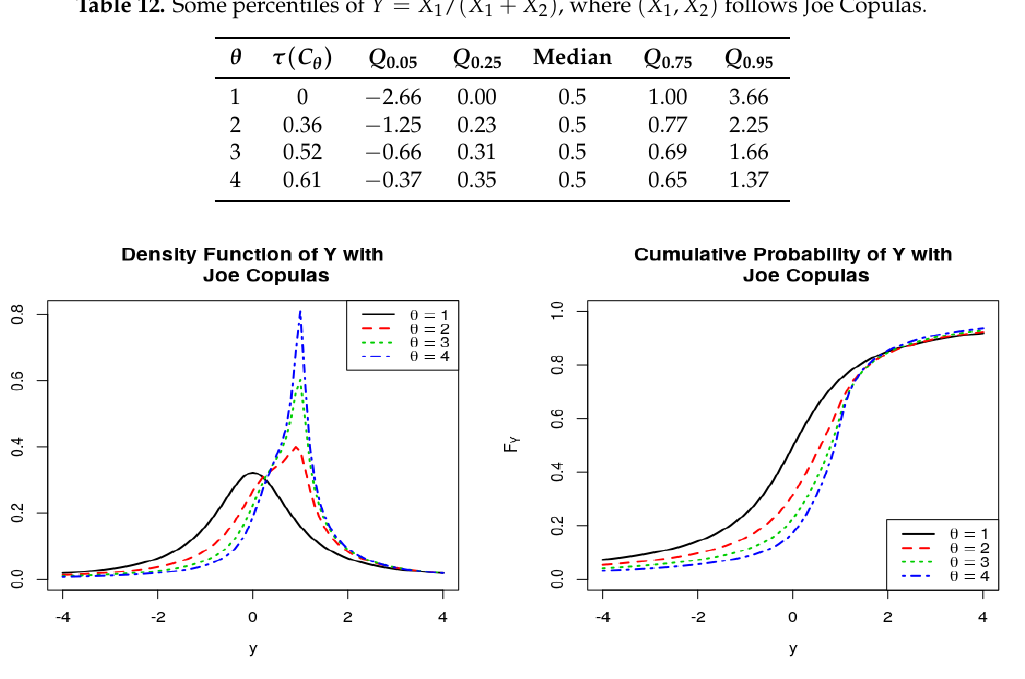
, where ( X 1 , X 2 ) follows Joe Copulas. X 2